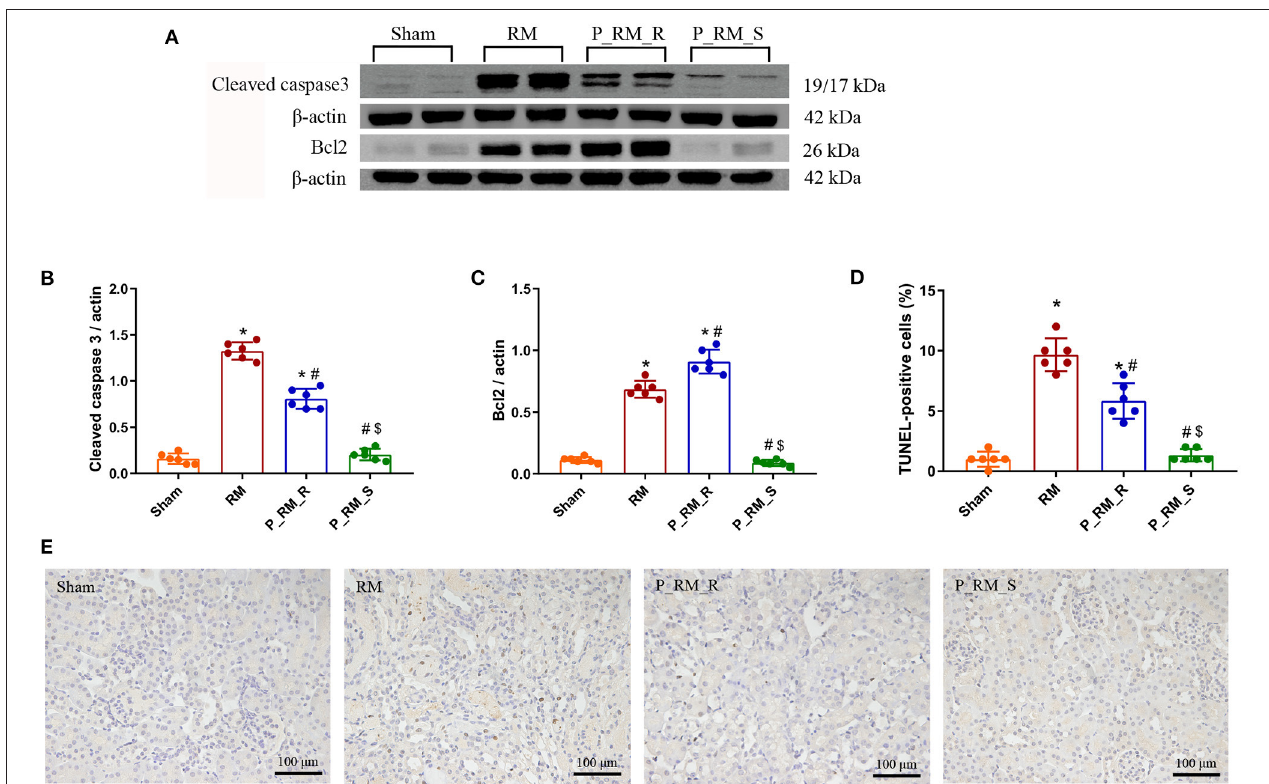
FIGURE 8 | Exogenous biological renal support decreased apoptosis in RM-induced AKI. (A–C) The levels of Bcl2 and cleaved caspase-3 were measured by Western blot analysis. (D) Percentage of TUNEL-positive tubular cells. (E) TUNEL staining. RM, rhabdomyolysis; P_RM_R, the mouse in the parabiosis model administered glycerol; P_RM_S, the other mouse in the parabiosis model supplying the exogenous biological renal support. * P < 0.05 vs. the sham group; # P < 0.05 vs. the RM group; $ P < 0.05 vs. the P_RM_R